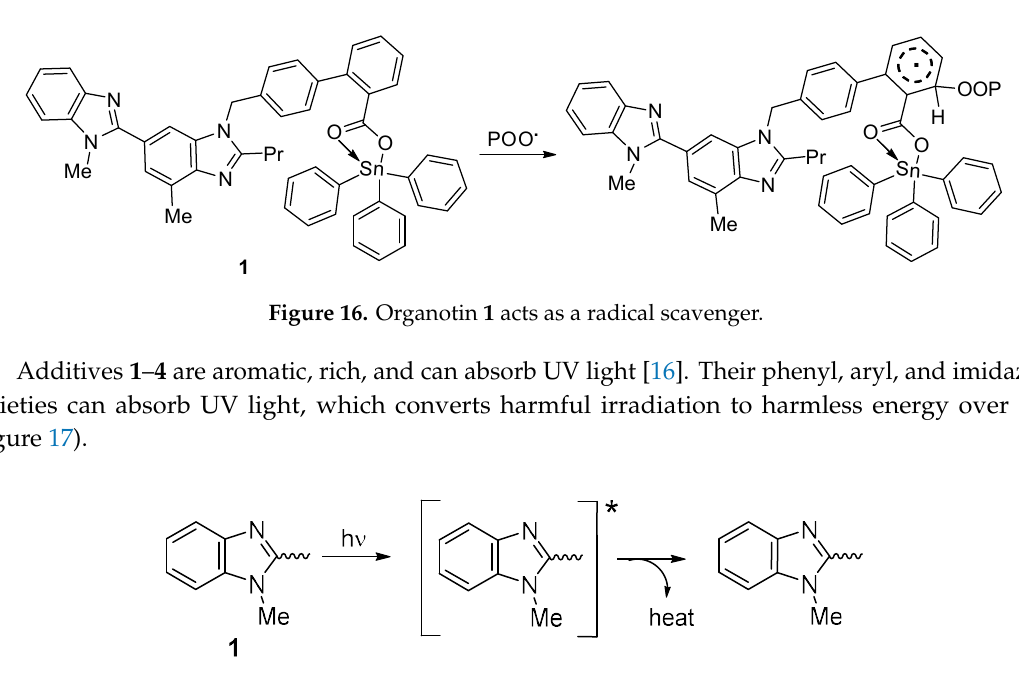
Figure 15. Organotin 1 acts as a peroxide decomposer.